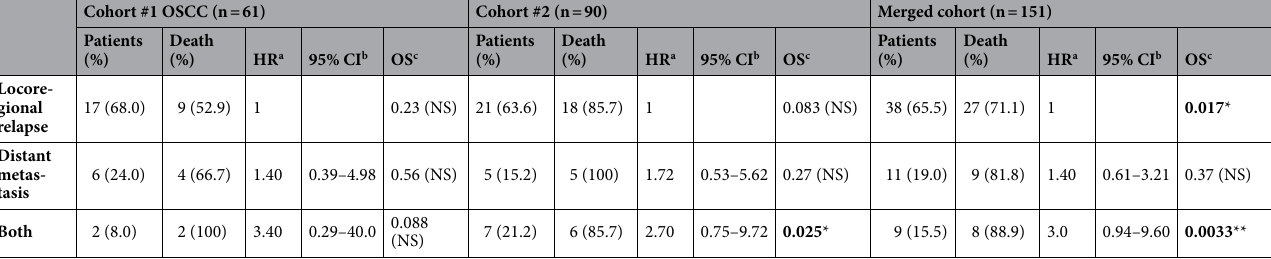
Table 1. Clinical, biological and pathological characteristics of the oral cavity (OSCC) patients sets: 61 patients from cohort #1, 90 patients of cohort #2 and 151 patients of the merged cohort, in relation with overall survival (OS). Significant ( p < 0.05) variables are highlighted in bold. OS: overall survival; NS: not significant; HPV: human papilloma virus; UICC: Union for International Cancer Control; ND: Undefined. * p < 0.05. ** p < 0.01. *** p < 0.001. a Hazard ratio (logrank). b 95% Confidence interval. c Log-rank test. d Information available for 48, 81 and 129 patients of cohort #1, cohort #2 and merged cohort respectively. e Information available for 52, 86 and 138 patients of cohort #1, cohort #2 and merged cohort respectively. f Information available for 56, 89 and 145 patients of cohort #1, cohort #2 and merged cohort respectively. g Information available for 56, 90 and 146 patients of cohort #1, cohort #2 and merged cohort Sensitivity analysis for the association of Fusobacterium nucleatum with OS in the merged cohort. In order to increase the study power, we performed a sensitivity analysis after grouping the two cohorts of patients with OSCC tumors (merged cohort, n = 151). Patients characteristics are described in Table 2. As previously observed, patients were mostly men (61.6%), ≥ 56 years (70.2%), non-drinkers (61.2%) but smok- ers (55.1%), with HPV-negative (97.4%), pN0 (53.6%), UICC stage IV (42.4%) tumors. In the merged cohort, 124 (82.1%) samples were positive for F. nucleatum (distribution of Nfn value displayed in Suppl. Figure 1), which was associated with older age (≥ 56 years: 74.2% vs. 51.9%, p = 0.021), fewer drinkers (34.9% vs. 60.0%, p = 0.034), and less frequent lymph node involvement (more pN0 tumors, 58.1% vs 33.3%, p = 0.0016) (Table 2). Positive pN status ( p = 0.0040) and higher UICC stage (stage ≥ II, p = 0.0036), presence of TP53 mutation (HR: 2.13, p = 0.0033), and tumor relapse (HR: 2.75, p < 0.0001) were prognostic indicators (Table 1). In the merged cohort, the outcome of the patients with a F. nucleatum -positive tumor was significantly better than that of the 27 patients with a F. nucleatum -negative tumor in term of OS (HR: 0.51, p = 0.0094; 5-year OS 60.5% vs. 37.7%; 10-year OS 47.9% vs. 18.8%) (Fig. 2E). Relapse‑free (RFS) and metastasis‑free survival (MFS) in the merged cohort. One hundred and fourty two patients were evaluable for disease relapse. There was a non-significant trend for less frequent disease recurrence in patients with F. nucleatum -positive tumors (35.5% vs. 51.8%, p = 0.11), with more locoregional (70.5% vs. 53.3%, p = 0.041) vs metastatic relapse compared to F. nucleatum -negative tumors (Table 2). RFS and MFS curves according to F. nucleatum status are displayed in Fig. 3. F. nucleatum -positive tumors were associated with significantly longer RFS (median: 7.06 vs. 2.11 months, p = 0.0091) and MFS (9.71 vs. 3.54 months, p = 0.0016) compared to F. nucleatum -negative tumors. Multivariate analysis of OS predictors and stratification according to pT and pN stage. Using a Cox proportional hazards model, we also assessed the prognostic value for OS of parameters that were signifi- cant in univariate analysis, i.e. pT, pN, UICC stage, TP53 mutation (Table 1) and F. nucleatum status (Fig. 2E). As pT/pN and UICC were redundant variables, the model was built with UICC stage, TP53 and F. nucleatum . The prognostic significance of these three parameters was maintained in Cox multivariate regression analysis (Table 3). In addition, we assessed the prognostic value of F. nucleatum on OS after stratification on pT and pN as main prognostic factors in OSCC. Interestingly, the combinations of pT1/T2 and F. nucleatum positivity (n = 49) and pN0 and F. nucleatum positivity (n = 72) identify a subgroup of patients with a very favorable survival (Fig. 4). Relationship between Fusobacterium nucleatum load and mRNA expression of immune‑related genes. To explore the underlying mechanisms of the favorable prognosis of F. nucleatum -positive tumors, as several studies recently suggested that F. nucleatum modulates the local immunity of various cancers (particu- larly, macrophages and Tregs) 18–20 , we tested possible association between F. nucleatum load and expression of various immune-related genes in 115 evaluable F. nucleatum -positive samples from the merged cohort (Suppl. Table 6). We observed a significant negative association between F. nucleatum load and markers of B lymphocytes (CD20, p = 0.027), T helper lymphocytes (CD4, p = 0.013), M2 macrophages (CD163, p = 0.020), and fibroblasts (PDGFRß, p = 0.0067). Toll-like receptor (TLR) 4 ( p = 0.020) and OX40 ligand (TNFSF4) ( p = 0.0067) expres- sions were significantly decreased in tumors with high F. nucleatum load. Notably, TNFSF9 receptor (TNFRSF9) expression was decreased ( p = 0.0067) while the expression of its ligand (TNFSF9) increased with F. nucleatum load, along with the pro-inflammatory cytokine IL-1ß ( p = 0.020). Correlations between F. nucleatum load and TNFSF4 , TNFSF9 , IL1B , and CD163 expression levels are displayed in Supplementary Fig. 3. There was no asso- ciation with cell proliferation and APOBEC genes.